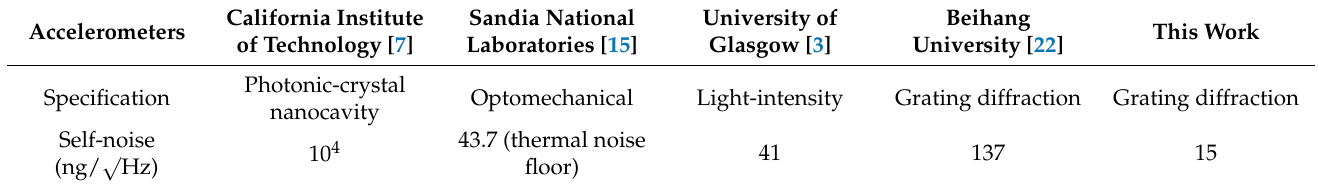
Table 4. The self-noise comparison between the proposed MOEMS accelerometer and other MOEMS